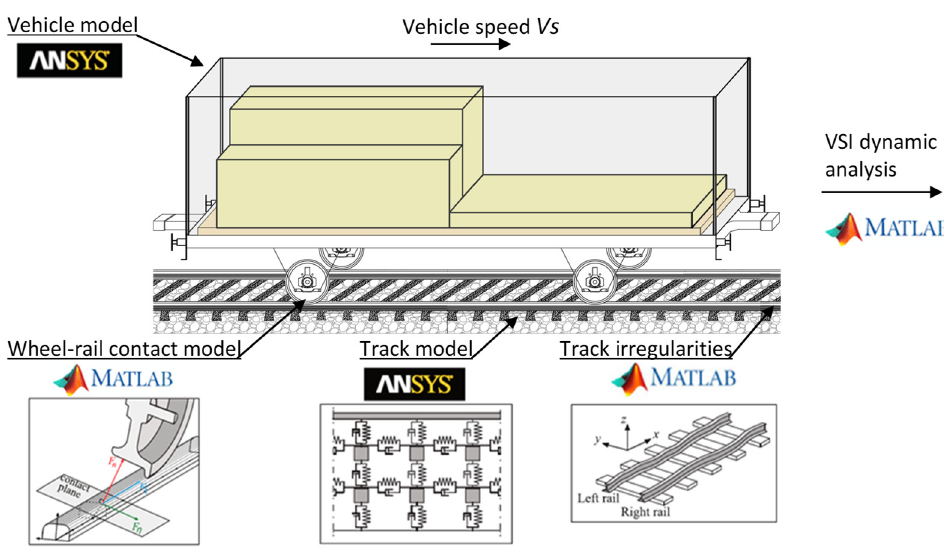
Figure 4. Vehicle–track interaction model schematization.